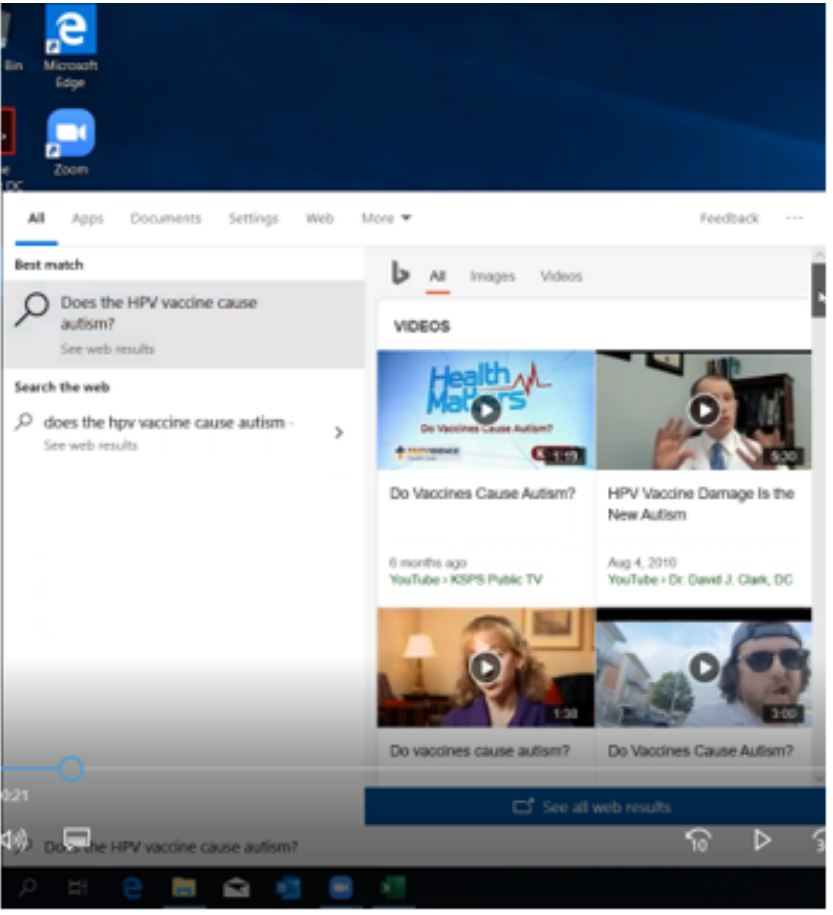
Figure 1. Example of a video result from a query to